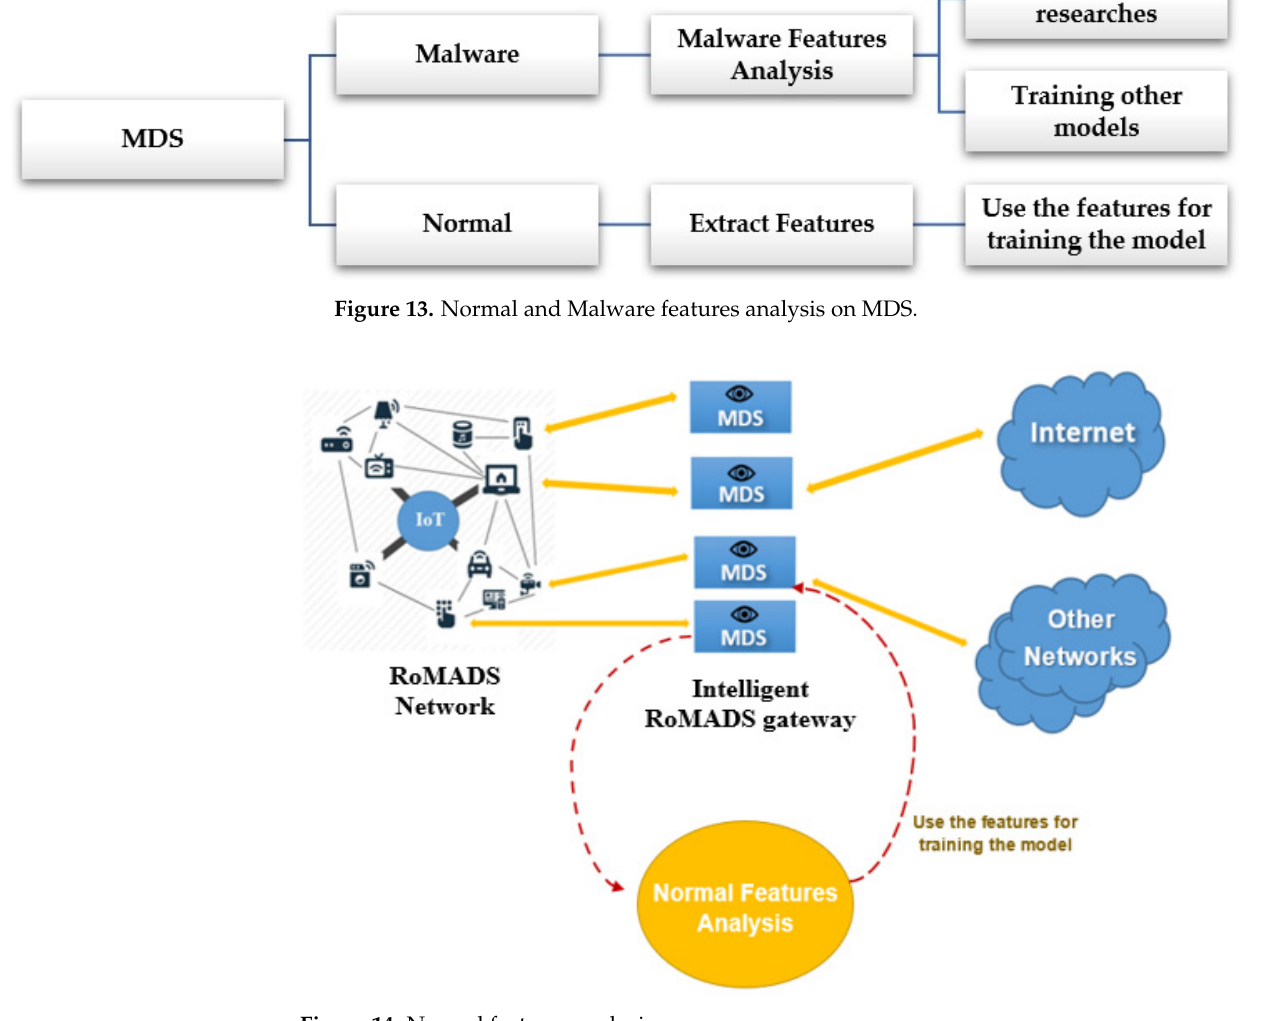
Figure 14. Normal features analysis.